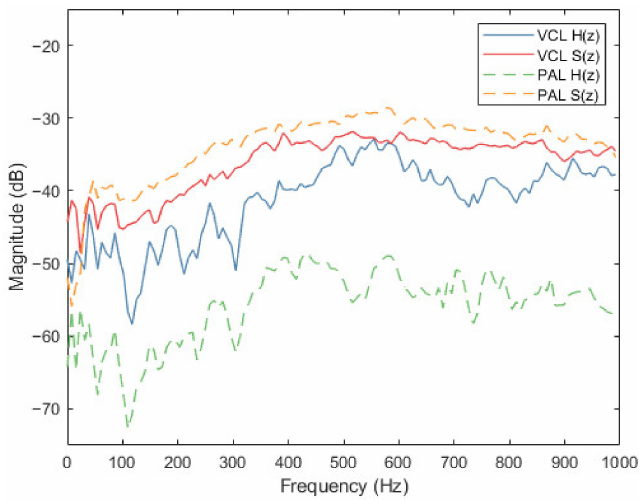
Figure 8. Amplitude frequency response of secondary path S(z) and feedback path H(z) of traditional VCL and